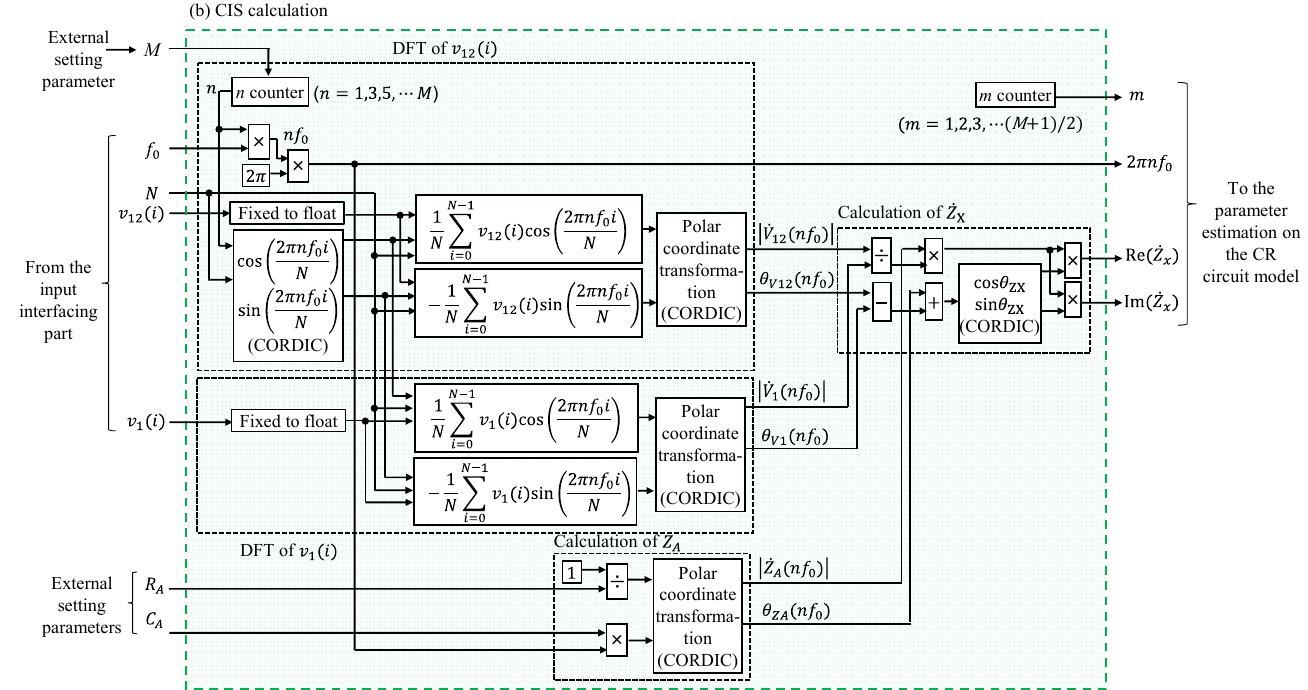
Figure 3. Detailed illustration of the CIS calculation module written in Figure 1.